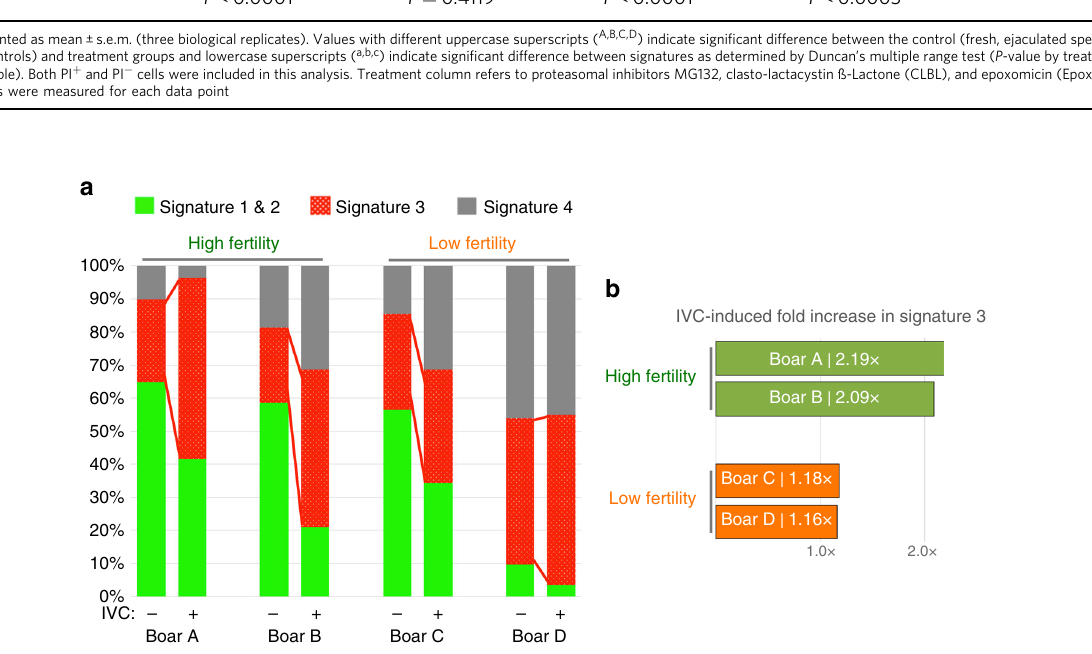
Fig. 5 Zinc signature associated with varied fertility in AI boars. a Zinc signature in four boars of known high or low fertility, before and after IVC. b High- fertility boars had double the amount of spermatozoa with signature 3 after IVC compared to minimal increase in low-fertility